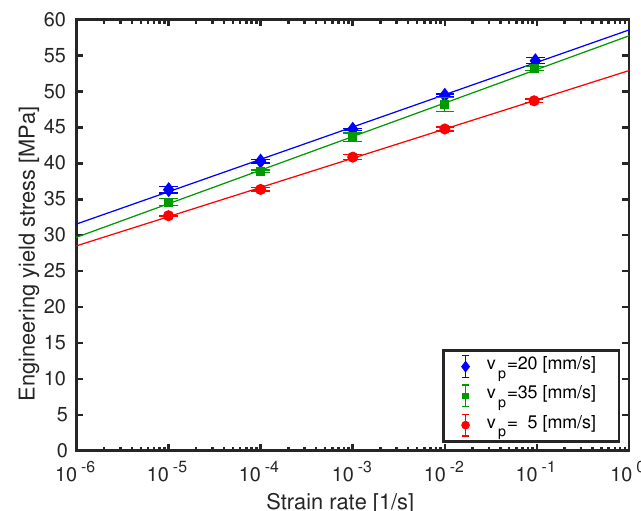
Figure 4. Void corrected engineering yield stress as a function of logarithmic strain rate for samples processed at three different printing velocities. Symbols are experimental results, solid lines are model